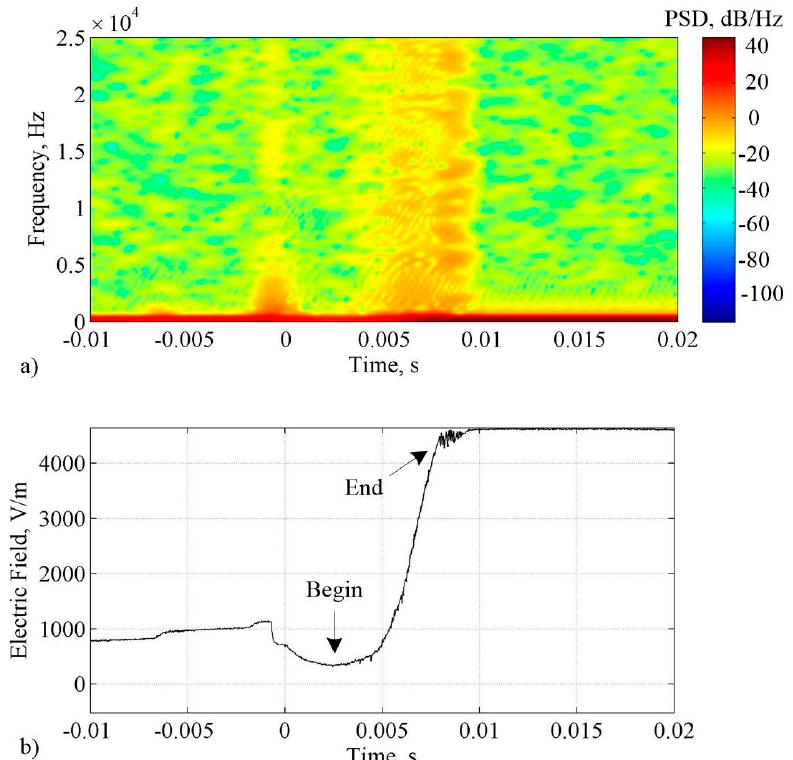
Figure 4. Analysis of positive lightning leader stage for the closest positive CG flash detected by the LOR on 8 July 2014 at 12:31:46.918851 UTC (the Case #4 in Table 1). The zero-time moment in this plot corresponds to the reported trigger timestamp. This leader stage is seen in the E-field record shown in panel ( b ), and its relevant PSD spectrogram is given in panel ( a ), where black arrows indicate the beginning and ending time moment during the evolution of the considered leader stage. The adopted STFT parameters for this presentation are as follows: window = 150 samples, overlap = 149 samples, FFT length = 150 samples and f S = 50 kHz.